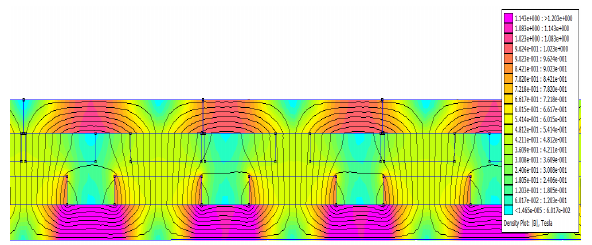
Fig. 4. Filed distribution in the machine with replaceable coils.